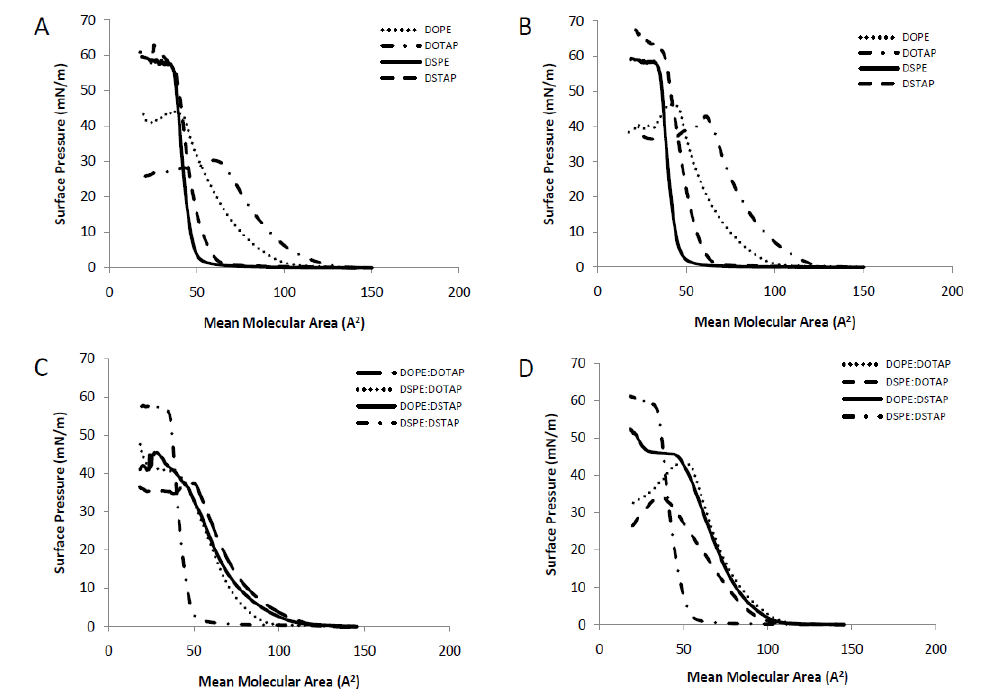
Figure 2. Compression isotherm studies of the pure and mixture of lipid monolayers of DOPE:DOTAP, DSPE: DOTAP,DOPE:DSTAP and DSPE:DSTAP in deionised water or PBS at 20 °C. Results are expressed as the means of three experiments. SD has not shown for